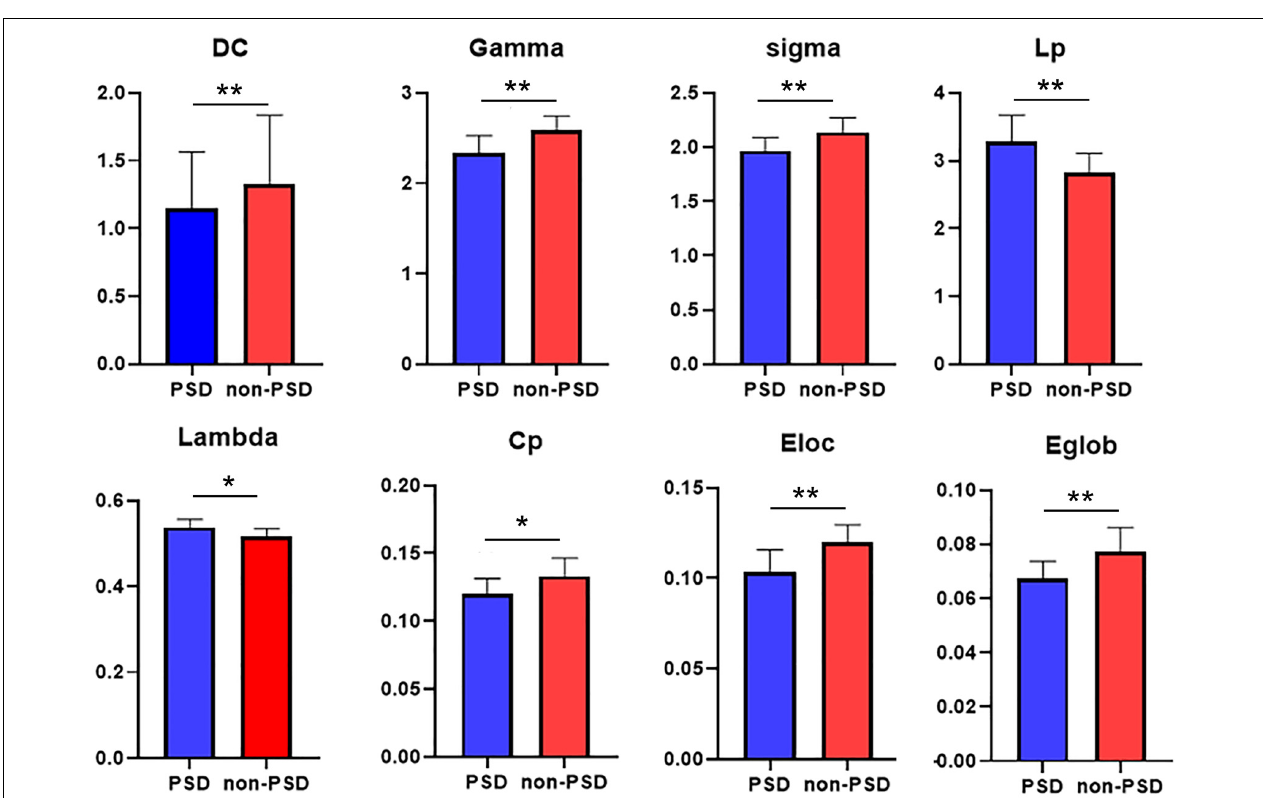
FIGURE 2 | Between group comparisons of global network measures. DC (degree coefficient), clustering coefficient (Cp), feature path length (Lp), normalized clustering coefficient ( γ ), standard feature path length ( λ ), small-world attribute ( σ ), global efficiency (Eglob), and local efficiency (Eloc; p < 0.05). The difference was statistically significant. * p < 0.05, ** p < 0.01. The color bar represents the Module and the size represents the weight of